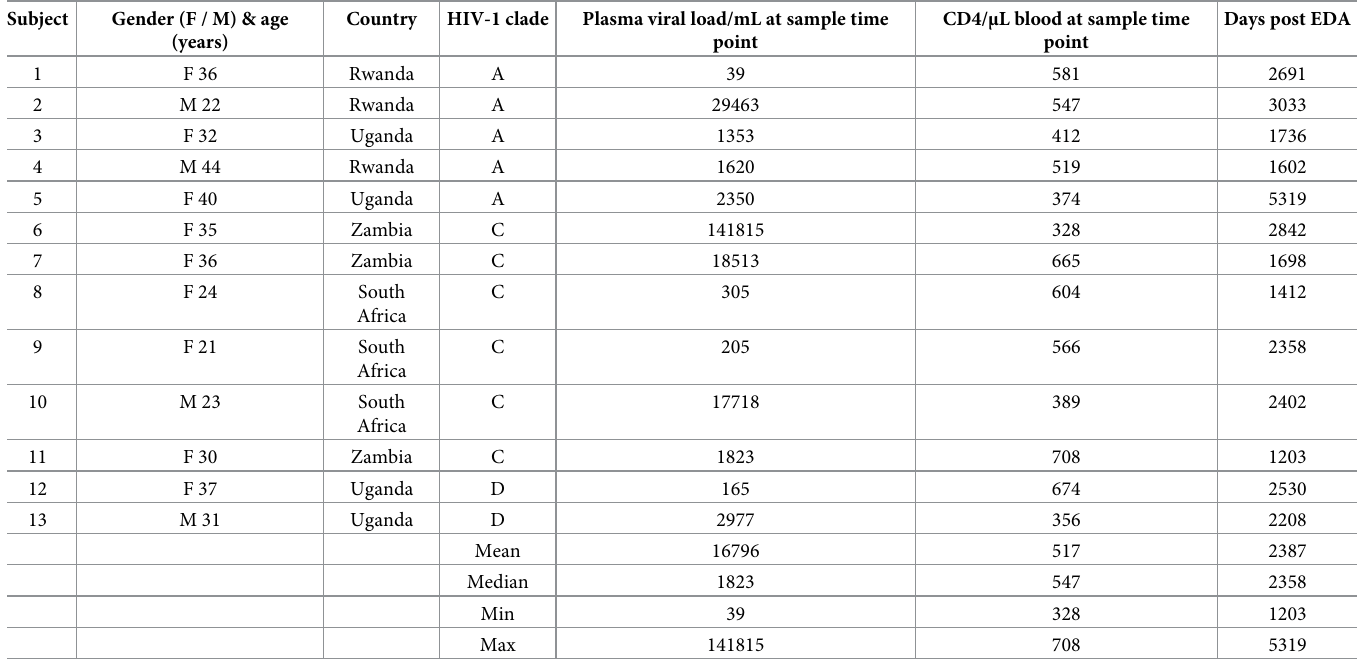
Table 1. Information for subjects living with HIV.